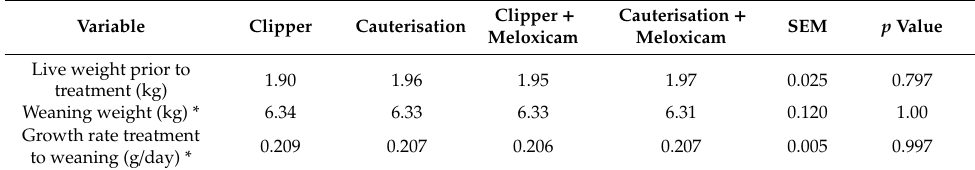
Table 4. E ff ect of treatment on growth performance of